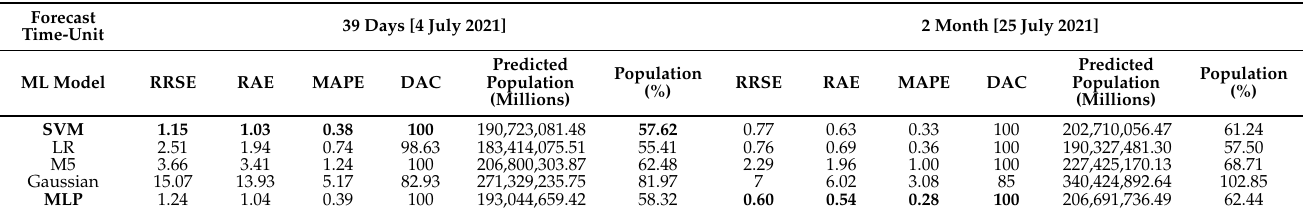
Table 8. Prediction accuracy and error for different machine learning models to forecast partially vaccinated population (at least one dose vaccine) in the